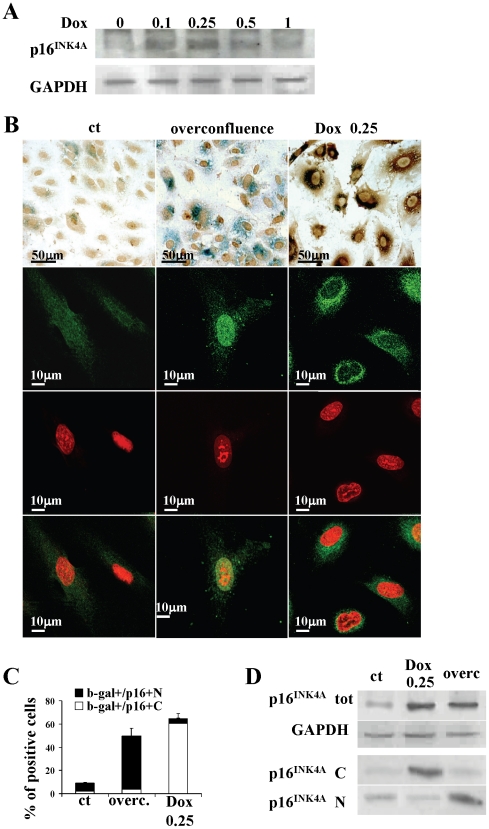
Prosenescent doses of doxorubicin increase p16INK4A protein levels with cytoplasmic accumulation.(A) Western blot analysis of p16INK4A expression in EPCs treated with various doses of doxorubicin. (B) Photographs show from left to right: control cells, cells cultured for four days after confluence (overconfluence), cells treated with 0.25 µM doxorubicin; first row: merge of SA-b-gal staining (blue) and immunocytochemistry for p16INK4A (brown) (magnification, ×400)); second row, p16INK4A immunofluorescence (magnification, ×1000); third row, nuclear staining with PI (magnification, ×1000); fourth row, merge of p16INK4A immunofluorescence and nuclear staining with PI (magnification, ×1000).(C) Bar-graph showing the percentage of SA-b-gal positive cells having nuclear (SA-b-gal+/p16+N) or cytoplasmic p16INK4A localizations (SA-b-gal+/p16+C) in control, overconfluent for four days or 0.25 µM doxorubicin treated cells. (D) Western blot analysis of p16INK4A expression in EPCs treated with 0.25 µM doxorubicin or cultured for four days after confluence. ct, control; Dox, doxorubicin; overc., overconfluence; tot, total; N, nuclear; C, cytoplasmic.